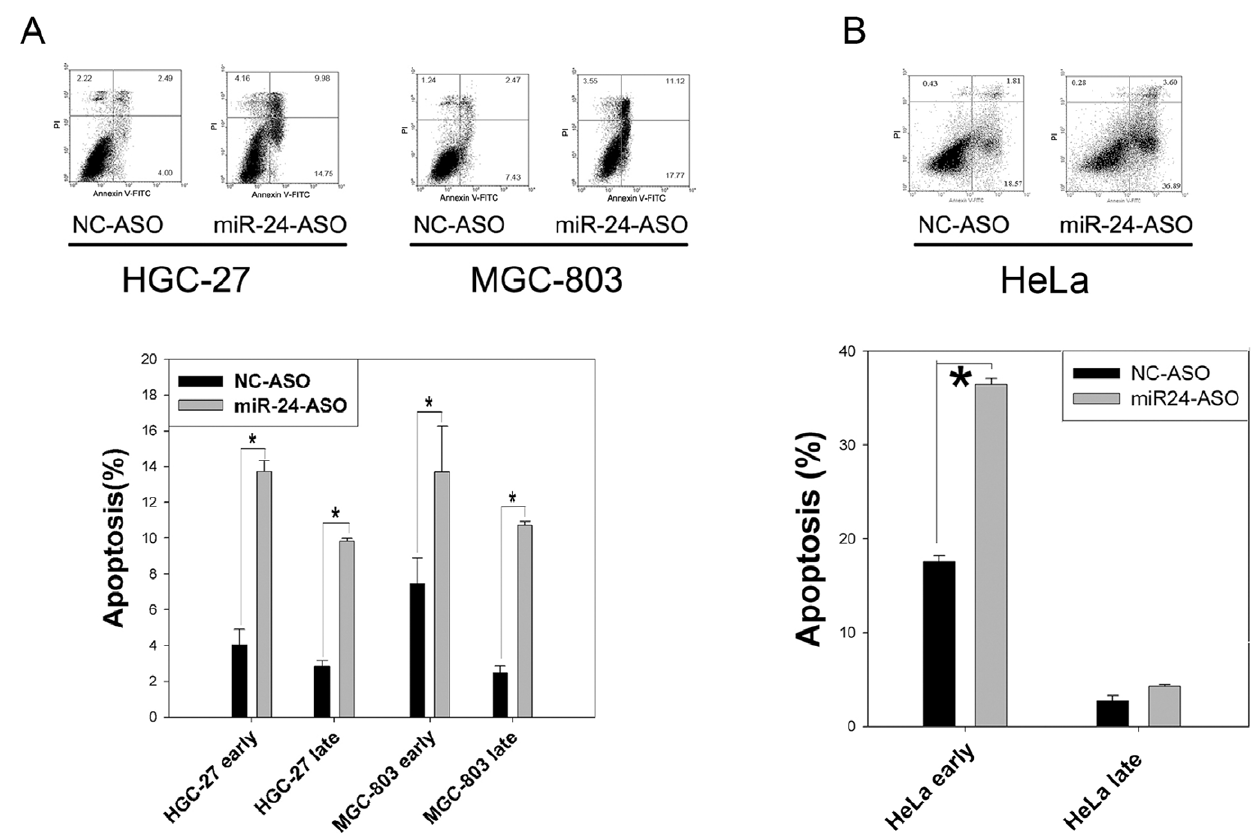
Figure 5. Down-regulation of miR-24 induced apoptosis in HGC-27 and MGC-803 cells, and increased staurosporine sensitivity in HeLa cells. (A) HGC-27 and MGC-803 cells were treated with 20 nM miR-24-ASO or NC-ASO and apoptosis was measured by FACS with Annexin V and propidium iodine staining after 48 h (n=3 6 SE; * p , 0.01). Down-regulation of miR-24 induced apoptosis in HGC-27 and MGC-803 cells. (B) Apoptosis was induced with 1 m M staurosporine for 2 h after 48 h of transfection using 20 nM miR-24-ASO or NC-ASO (n=3 6 SE; * p , 0.01). The apoptotic response to staurosporine was increased after transfection with miR-24-ASO.